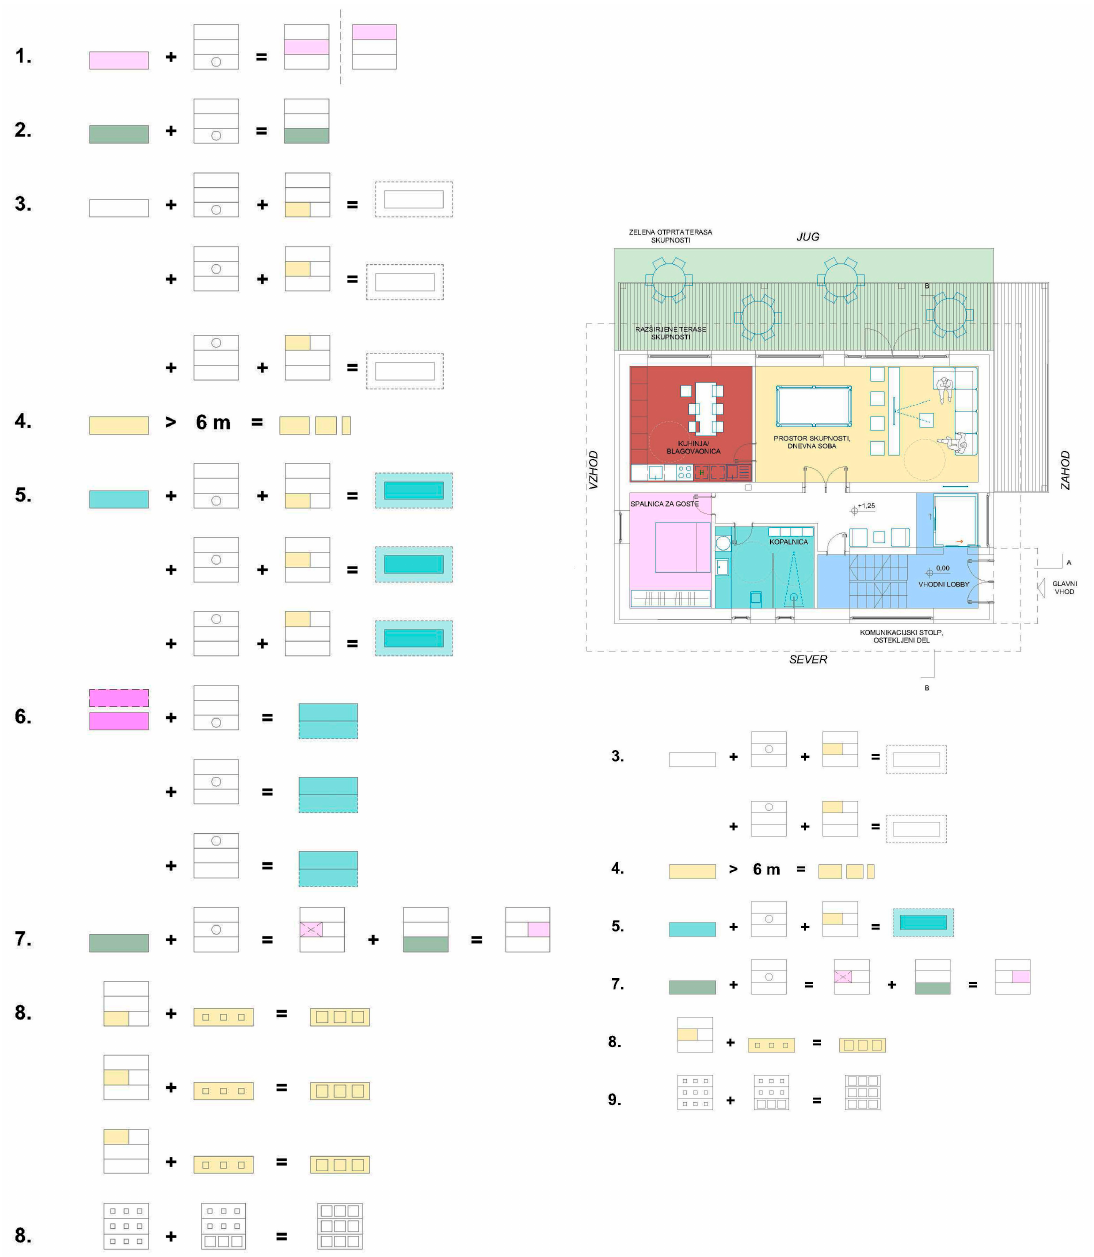
Figure 6. Another example of the shape grammars developed by the students. Authors: attendees of Student Workshop 2, 2022.